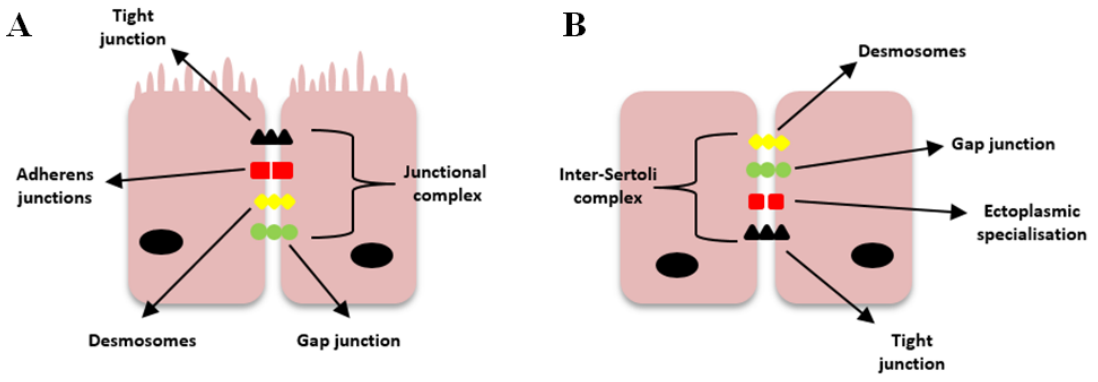
Figure 2. Diagram illustrating the di ff erence between epithelial cells ( A ) and seminiferous epithelia ( B ). Tight Junctions (TJs) between Sertoli cells are located in the basal part of the cells, while in other epithelial cells, they are located in the apical part. Between Sertoli cells occur “ectoplasmic specialization”, which is a testis-specific